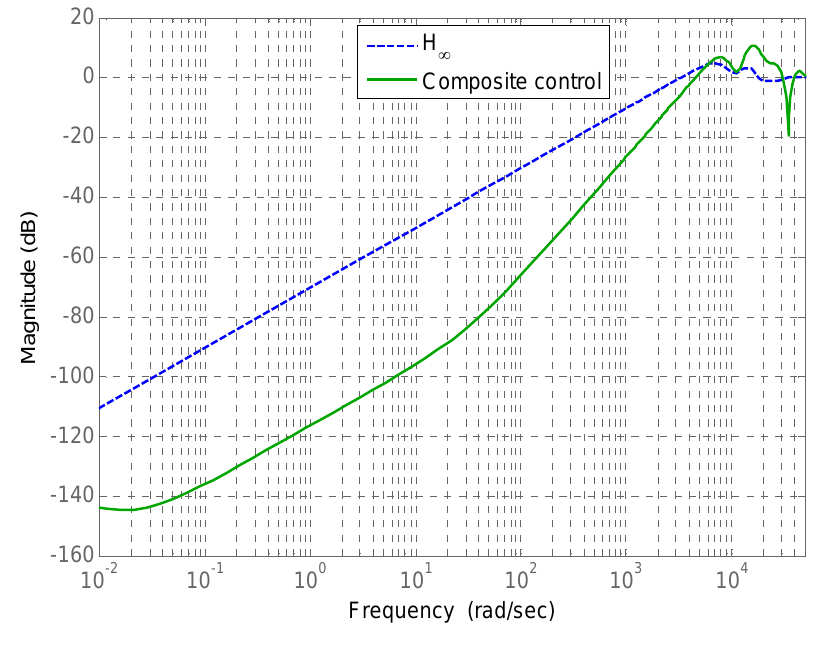
Figure 11. Bode diagrams of the sensitivity function of the H composite